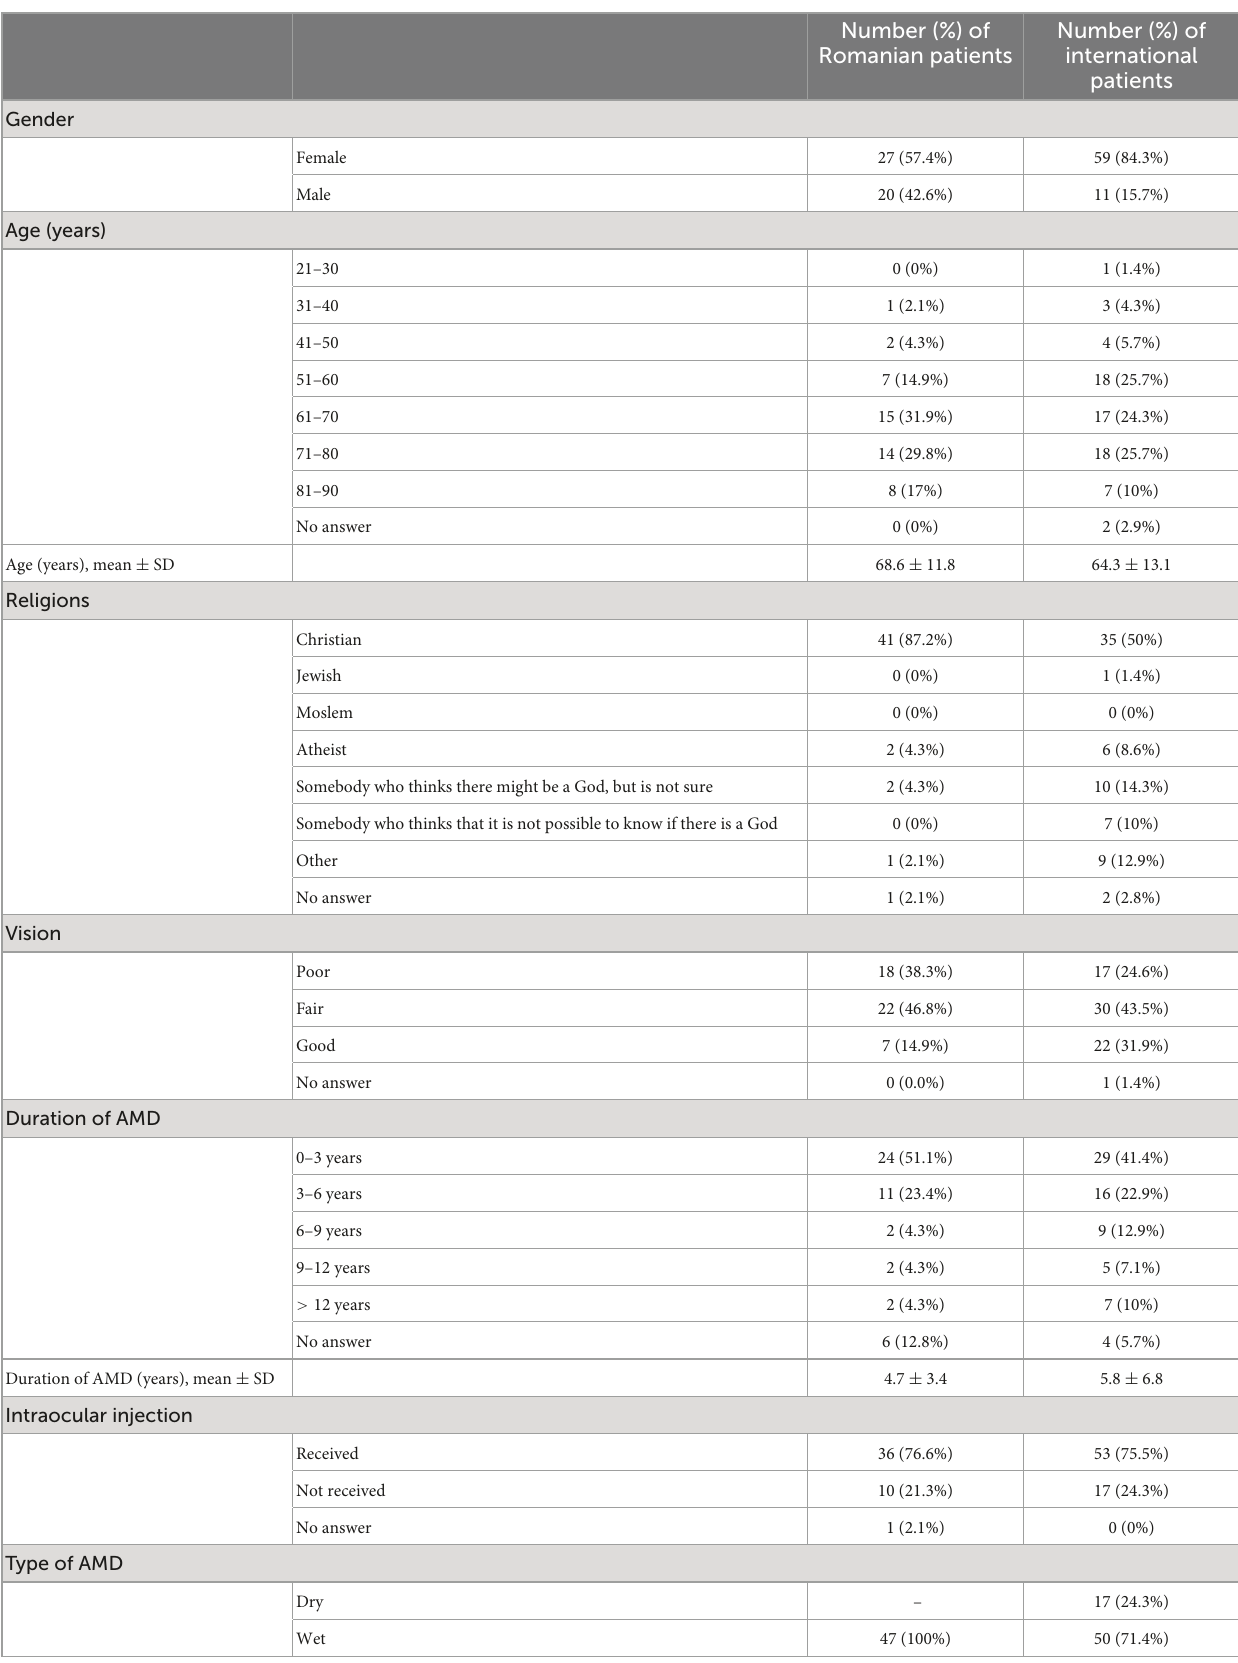
TABLE 1 Demographics of 117 patients and the duration and stage of AMD.